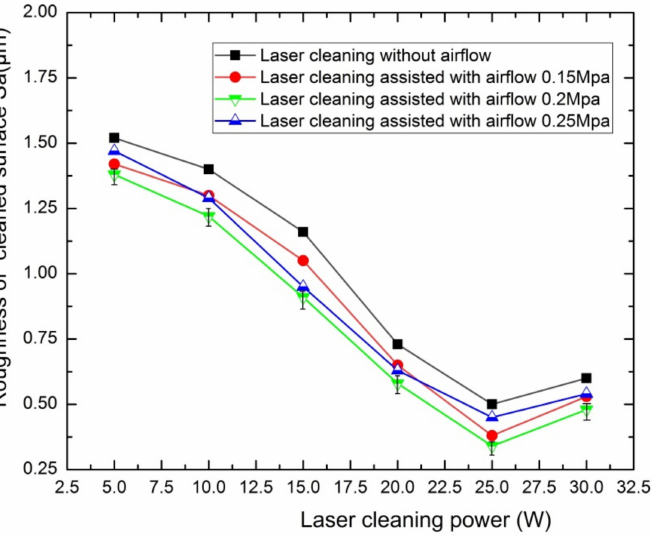
Figure 9. Roughness of cleaned surface varying with different laser cleaning